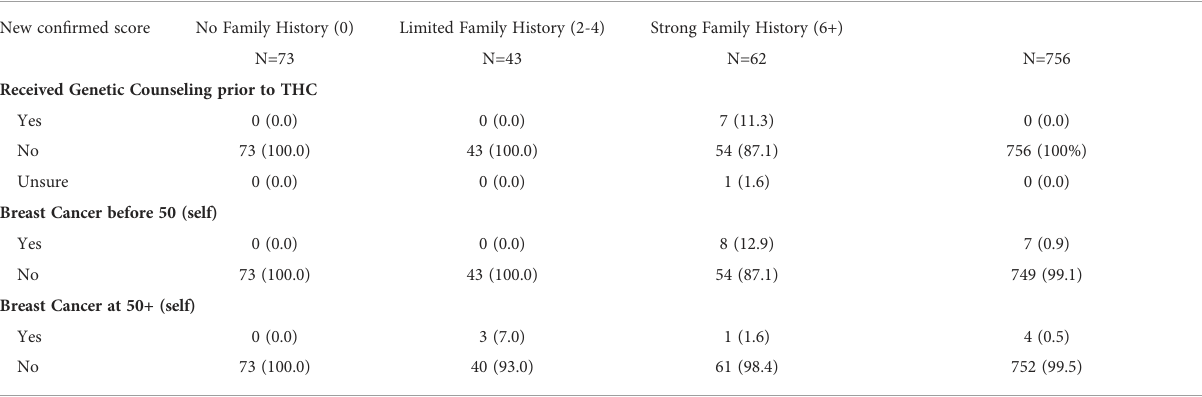
TABLE 7 Breast cancer family history score and personal history of breast cancer by post con fi rmation score, among individuals originally placed in the ‘ Strong Family History ’ category.